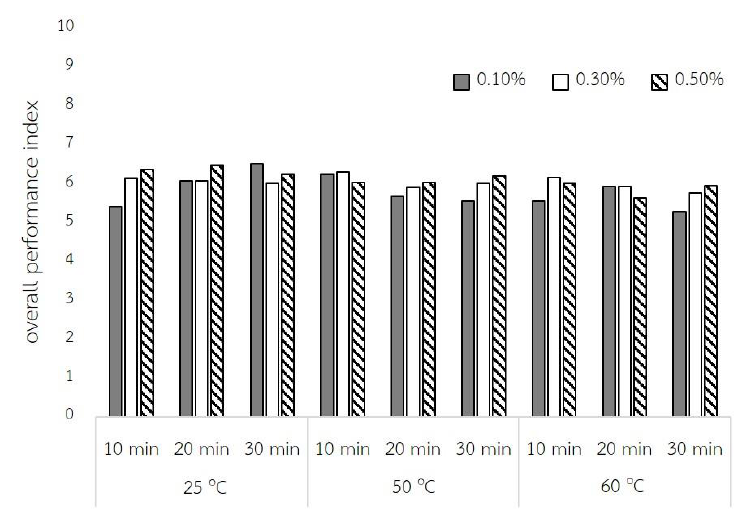
Figure 6. The overall performance index of each QBJR sample.